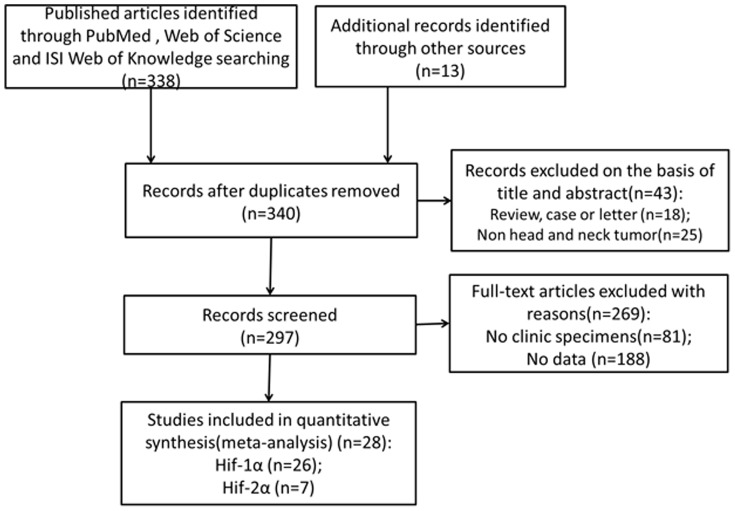
Flow diagram of study selection procedure.